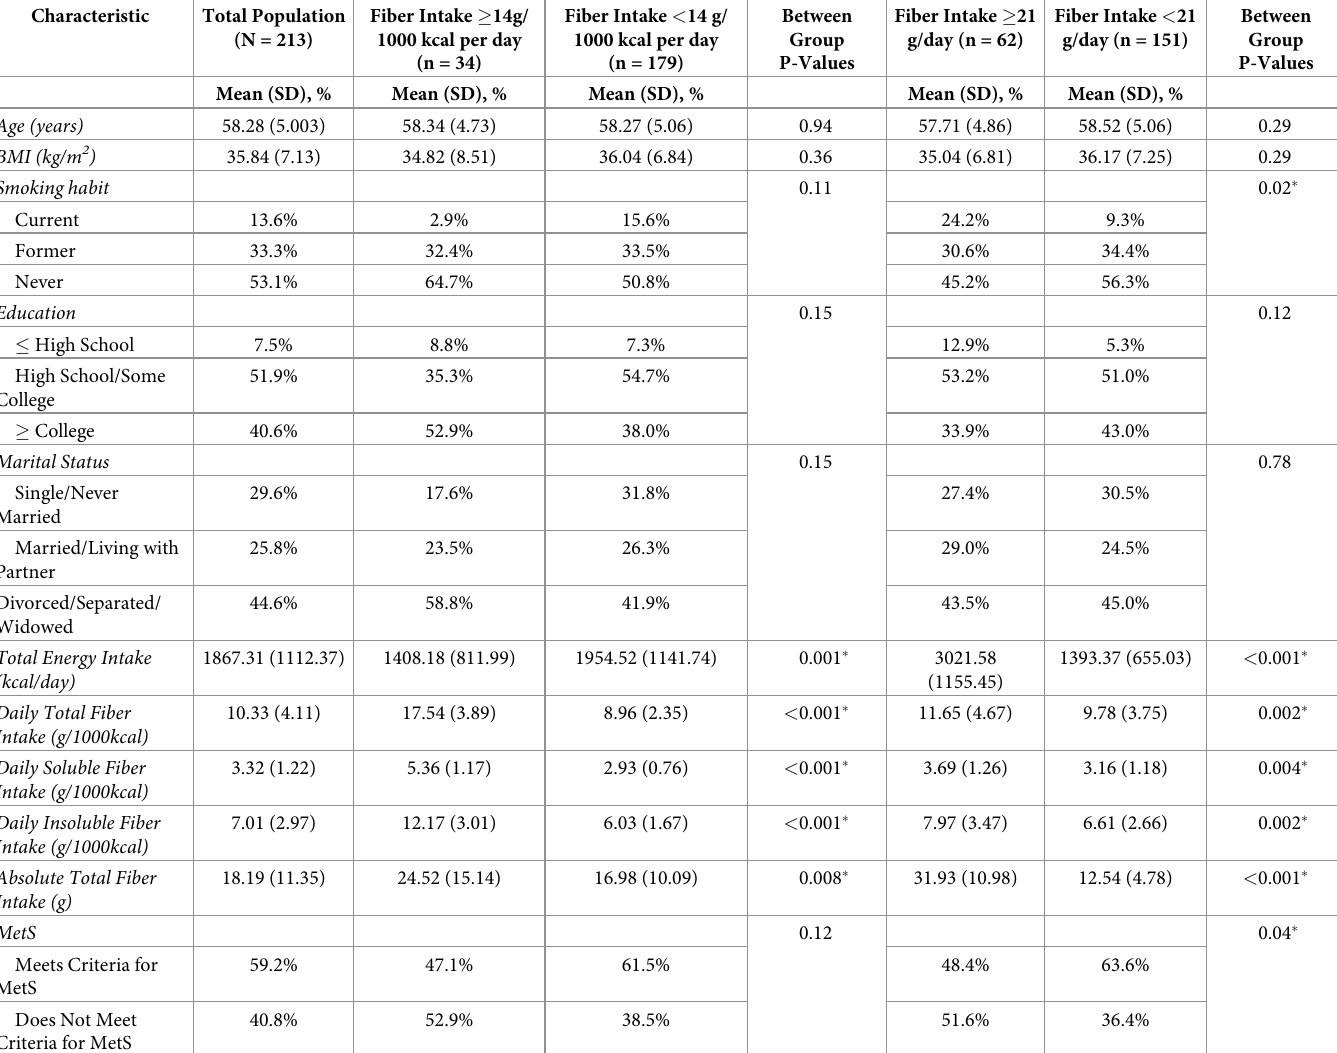
Table 1. Baseline characteristics and metabolic syndrome by fiber intake